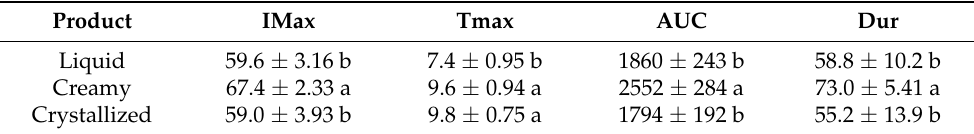
Table 7. Time intensity parameters ( ± SEM) for the rape honey overall olfactory intensity. Product Liquid